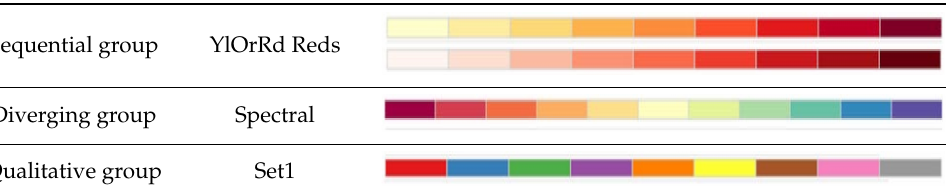
Table 1. Color schemes used to represent maps in the